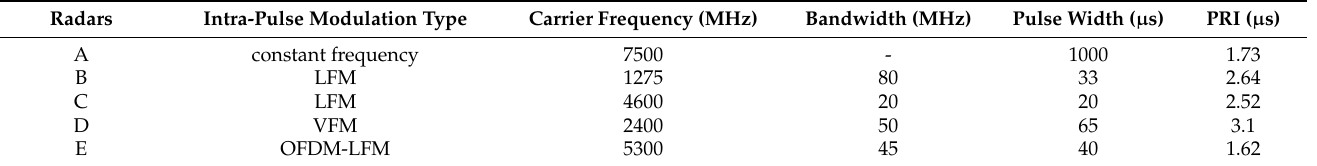
Table 1. Parameter settings of radars.